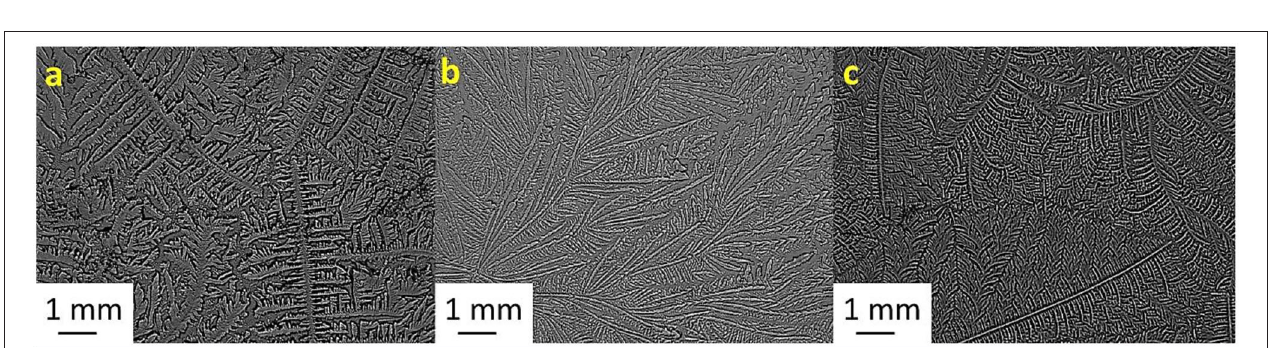
FIGURE 2 | Tear ferning patterns of (a) S2, (b) S2 and KCl (1:1), and (c) S2:MgCl 2 .6H 2 O (1:8). S2, second sheep tear sample.